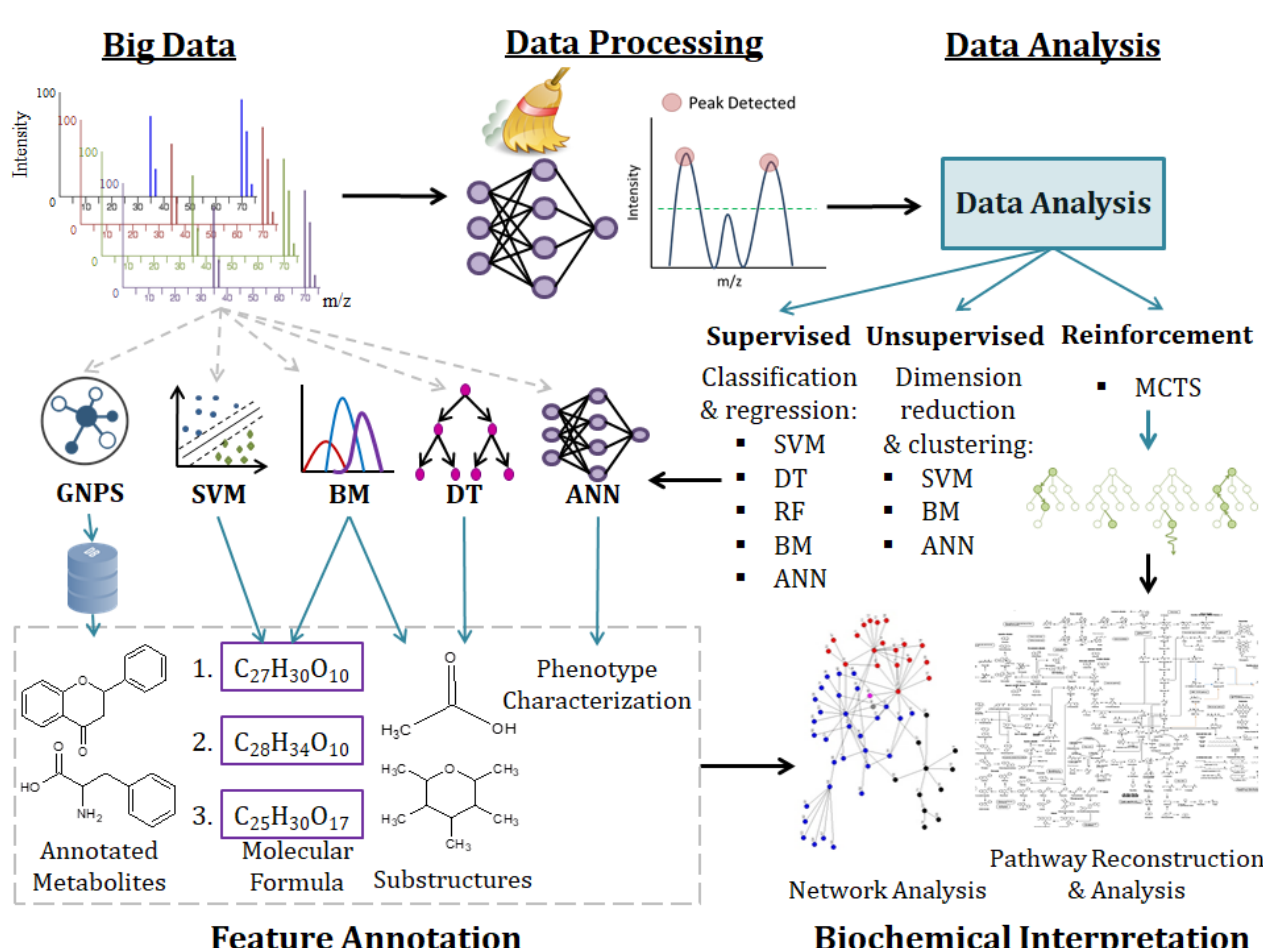
Figure 3. Workflow for metabolomics data analysis and biochemical interpretation with machine and deep learning algorithms. Various machine and deep learning algorithms are implemented all through the analysis and interpretation workflow. Artificial neural networks (ANNs) implemented in data processing remove noise and artifacts from raw data by performing peak detection and alignment. In data analysis, ANNs, support vector machines (SVMs) and Bayesian models (BMs) may be applied as either unsupervised or supervised methods and, in the former, they explore and reduce the dimensionality of the data. The supervised analysis with SVMs, decision trees (DTs), random forest (RF), BMs and ANNs, classify and extracts/selects relevant features from the dataset for feature annotation. Selected features from data analysis are used as input data for GNPS, SVMs, BMs, DTs and ANNs. Raw spectral data may also be used as input data. GNPS queries the data against its spectral library to annotate the selected features. SVMs and BMs predict and rank the features molecular formula. Additional BMs and DTs extract substructures from the data. ANNs characterize phenotypes from the data. The annotated features are integrated and applied for network analysis, pathway reconstruction and analysis. Abbreviations: ANN, Artificial neural network; SVM, Support vector machine; BM, Bayesian model; DT, Decision tree; RF, Random forest; MCTS, Monte Carlo tree search; GNPS, Global Natural Product Molecular Networking.